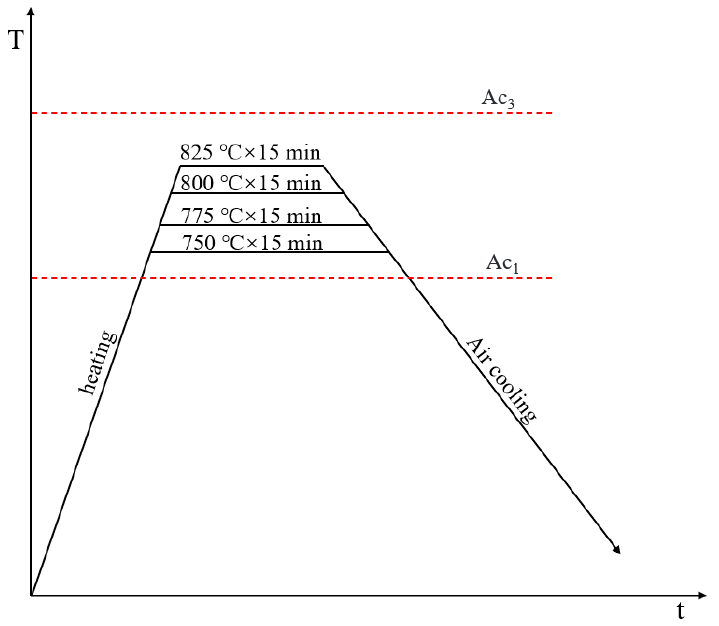
Figure 2. Schematic diagram of the heat treatment process of LH800 steel.